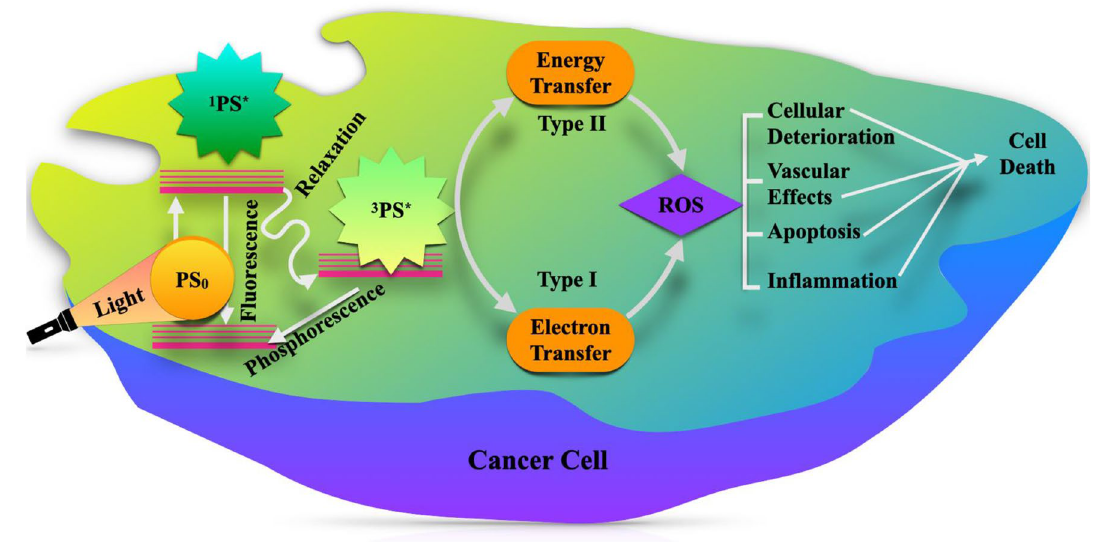
Figure 14. The plausible mechanism of PDT leading to cell